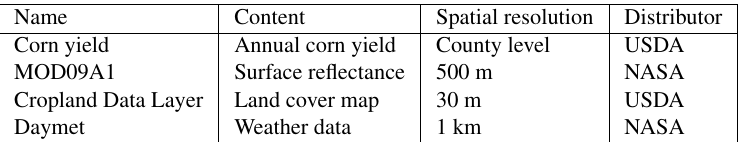
Table 1: The dataset in this study